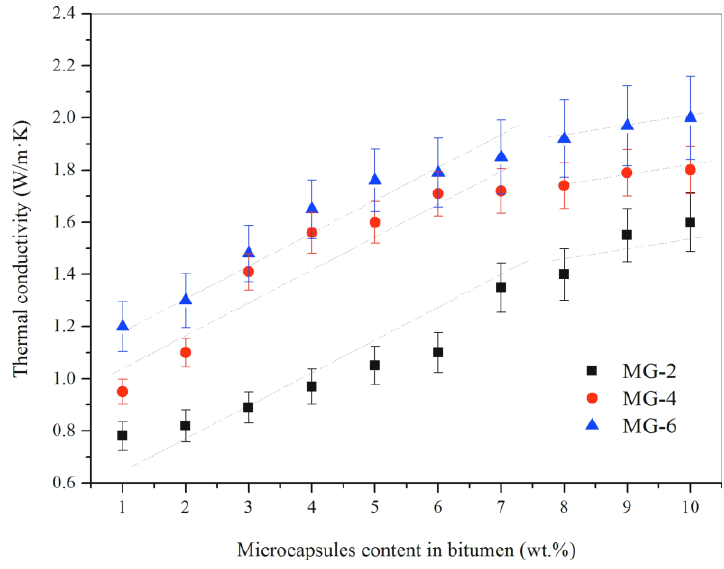
Figure 11. Thermal conductivity of bitumen samples with various weight contents (1 – 10%) of graphene microcapsules (MG-2, MG-4 and MG-6).